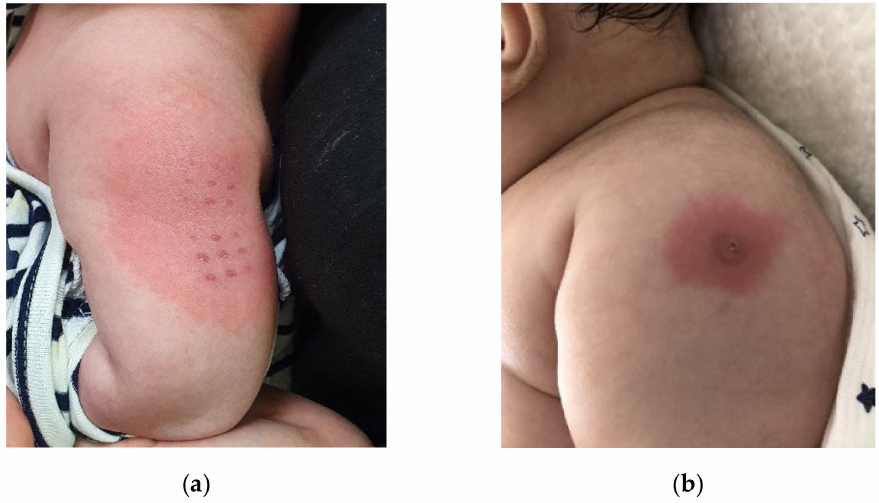
Figure 1. Erythema at the site of Bacille Calmette-Guerin (BCG) inoculation following two different delivery methods. ( a ) Transdermal method ( b ) Intradermal